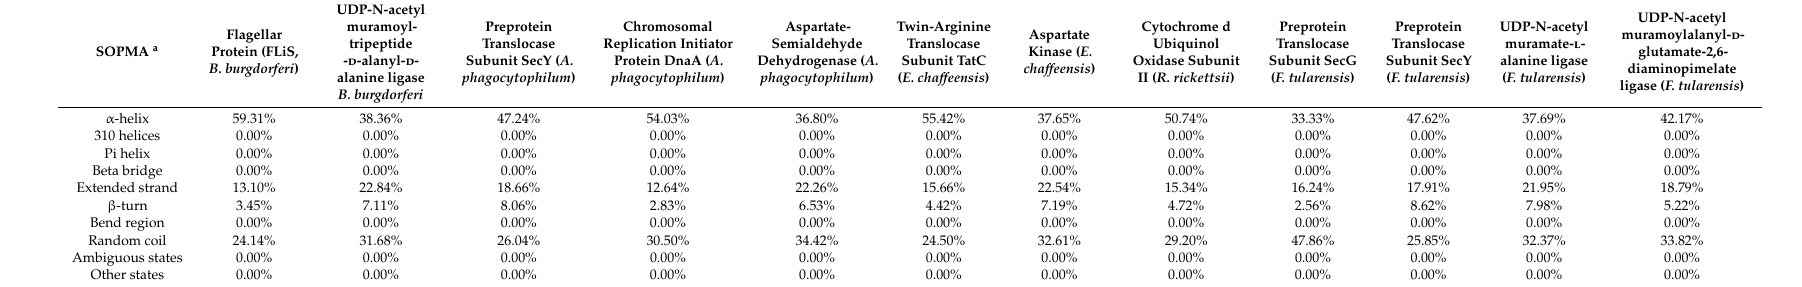
Table 3. Secondary structure prediction of drug targets and vaccine